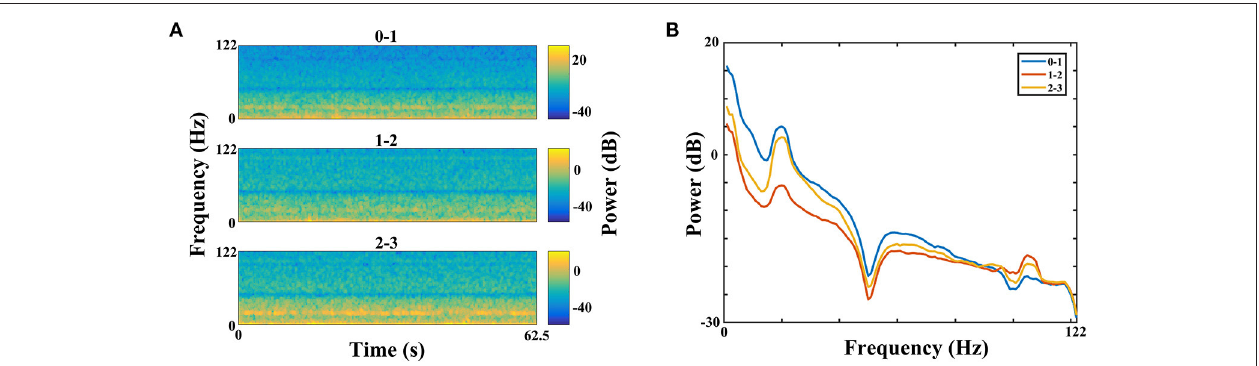
FIGURE 2 | Time–frequency spectrograms (A) and PSDs (B) of LFPs from all three electrode pairs (0–1, 1–2, and 2–3) of STN in a representative patient (B, blue = 0–1, red = 1–2, yellow = 2–3). (A) The spectrogram has one axis (X-axis) for the time domain (s) and one axis (Y-axis) for the frequency domain (Hz) and uses color to represent power levels (dB). The color legend is displayed to the right of each spectrogram. Visual inspection of the maps indicated distinct beta band (13–30Hz) and less obvious gamma band (100–110Hz) activity. (B) The PSDs indicated that increased amplitudes of beta and gamma oscillations were present in this subject. The X-axis represents frequency (Hz), and the Y-axis represents power (dB). Blue line: PSD from contact pair 0–1; red line: PSD from contact pair 1–2; yellow line: PSD from contact pair 2–3. PSD, power spectral density; LFP, local field potential; STN, subthalamic nucleus.